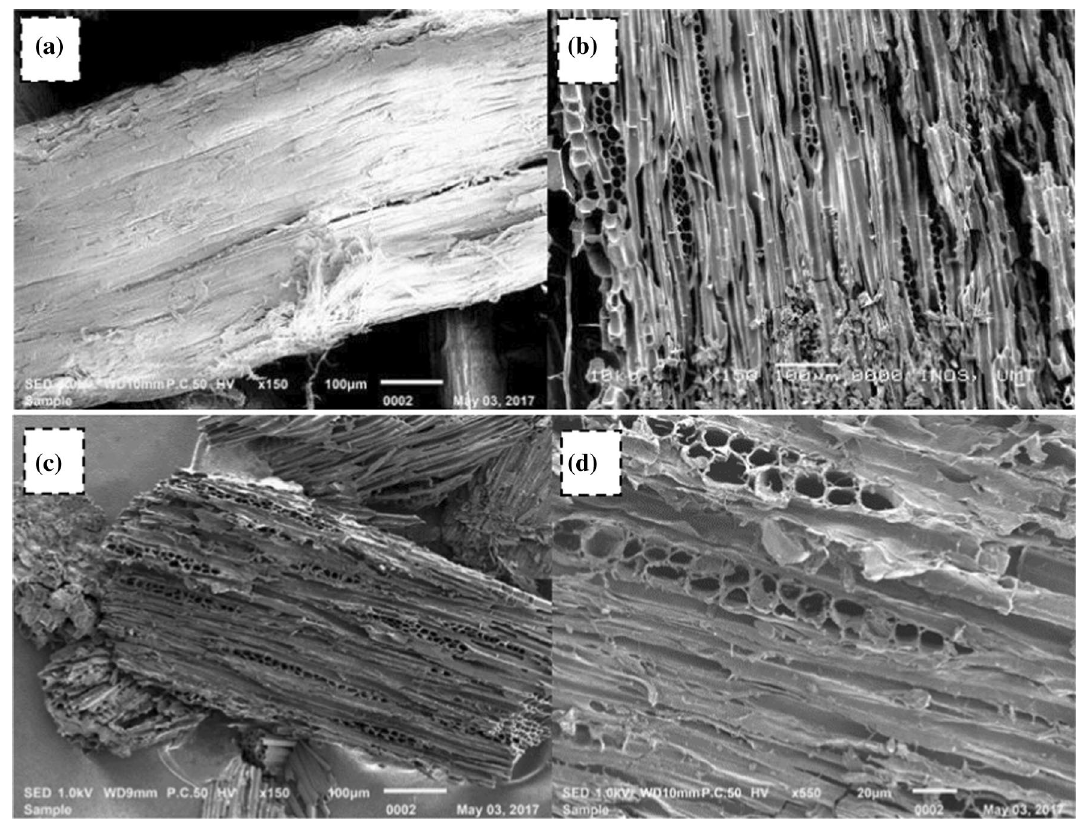
Fig. 1 SEM images of Leucaena leucocephala before carbonization a , after carbonization b , and after activation c at magnification 150x as well as activated carbon at magnification 550x d